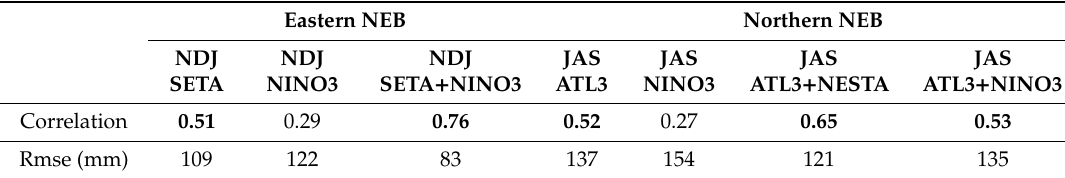
Table 3. Skill of the linear regression forecast of Eastern and Northern NEB rainfall using some oceanic indexes. The indexes used for the May–July Eastern NEB rainfalls are the southeastern tropical Atlantic (SETA; 10 ◦ S–20 ◦ S, 10 ◦ W–5 ◦ E) and NINO3 (5 ◦ N–5 ◦ S, 150 ◦ W–90 ◦ W) in NDJ. For the